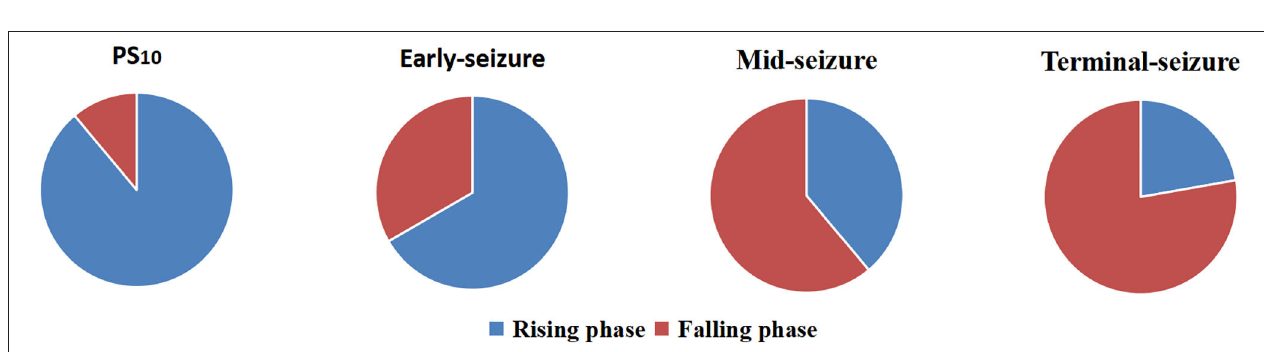
FIGURE 2 | Temporal specificity of the PAC. The top panel shows channels that had the strongest PAC during the selected period. The channel 12 (Ch12) was located in the SOZ (marked red); Ch21, Ch24, and Ch51 were inside the resection margin but not in SOZ (marked blue); Ch76 was not in the resection margin and SOZ (marked black). The time intervals were shown below each trace. The ECoG segments with the most strongest PAC of the periods were marked by the red horizontal line. The most strongest PAC varied in different channels at the different period. The MI co-modulation of these ECoG segments are shown in the middle panel. In the middle panel, all axis labels are indicated on the leftmost sub-figure, and the scales are indicated by the color bar on the right side of each sub-figure. We found that the strength and frequency of PAC varies over time. The phase-amplitude polar histograms of these ECoG segments are shown in the below panel. We found that the preferred phases in the IS, PS, PS 10 , and early-seizure periods were in the rising phase (– π ∼ 0), while in the Mid-seizure, Terminal-seizure and Post-seizure periods, it was in the falling phase (0 ∼ π ).